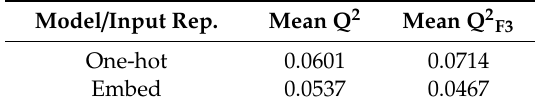
Table 2. Q 2 values and Q 2 F3 values for various models with log IC 50 output.